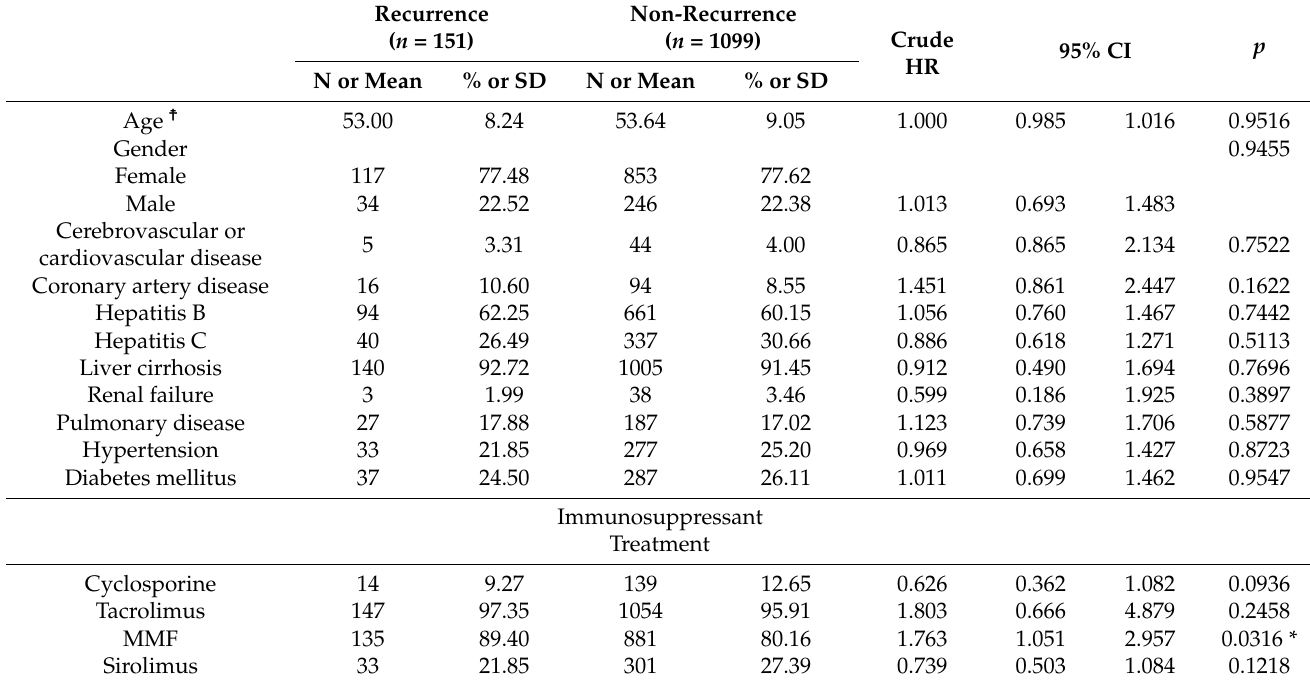
Table 1. Demographic Data and Clinical Characteristics of the Liver Transplant Recipients in the Study Case (HCC Recurrence) and Control (Non-HCC Recurrence) Groups.